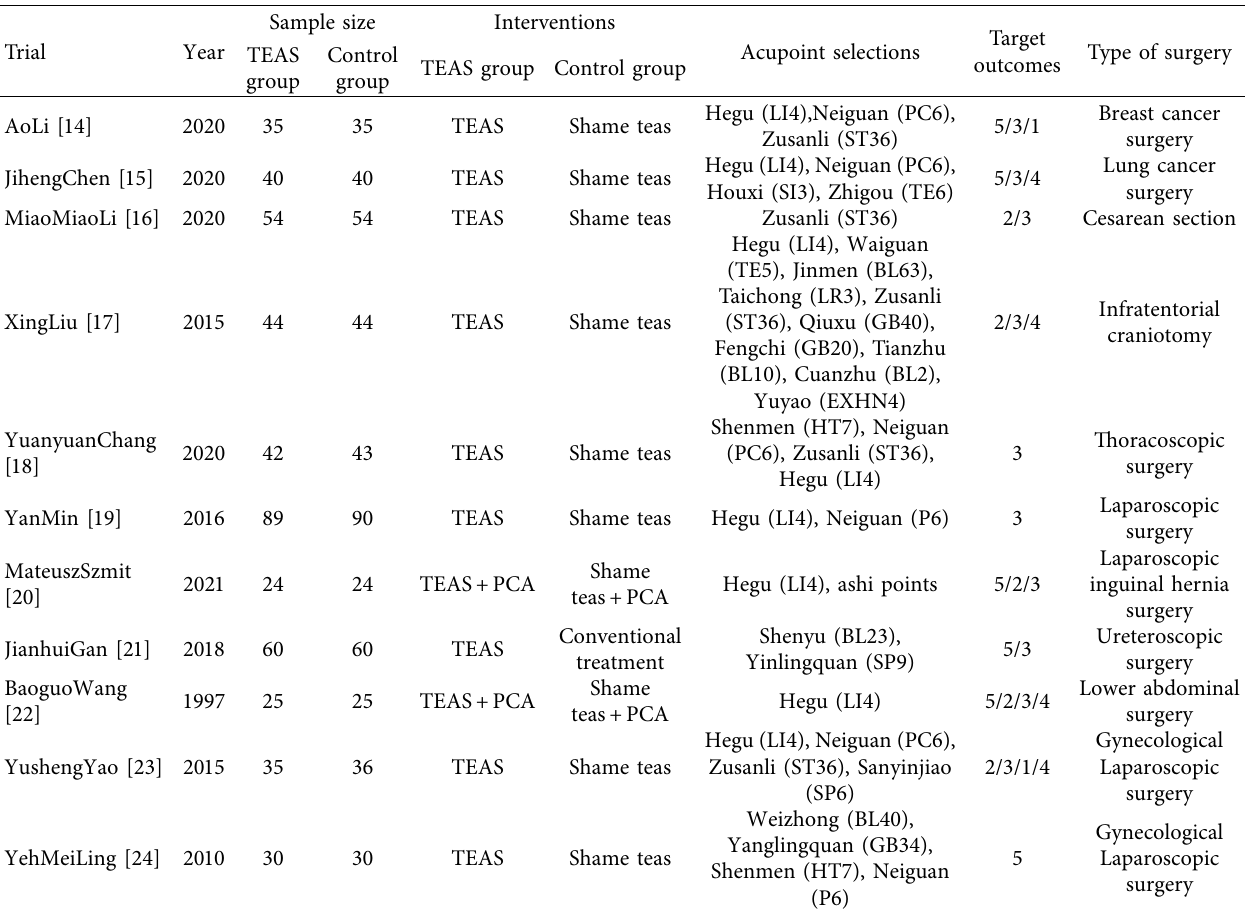
Table 2: Characteristic of the included